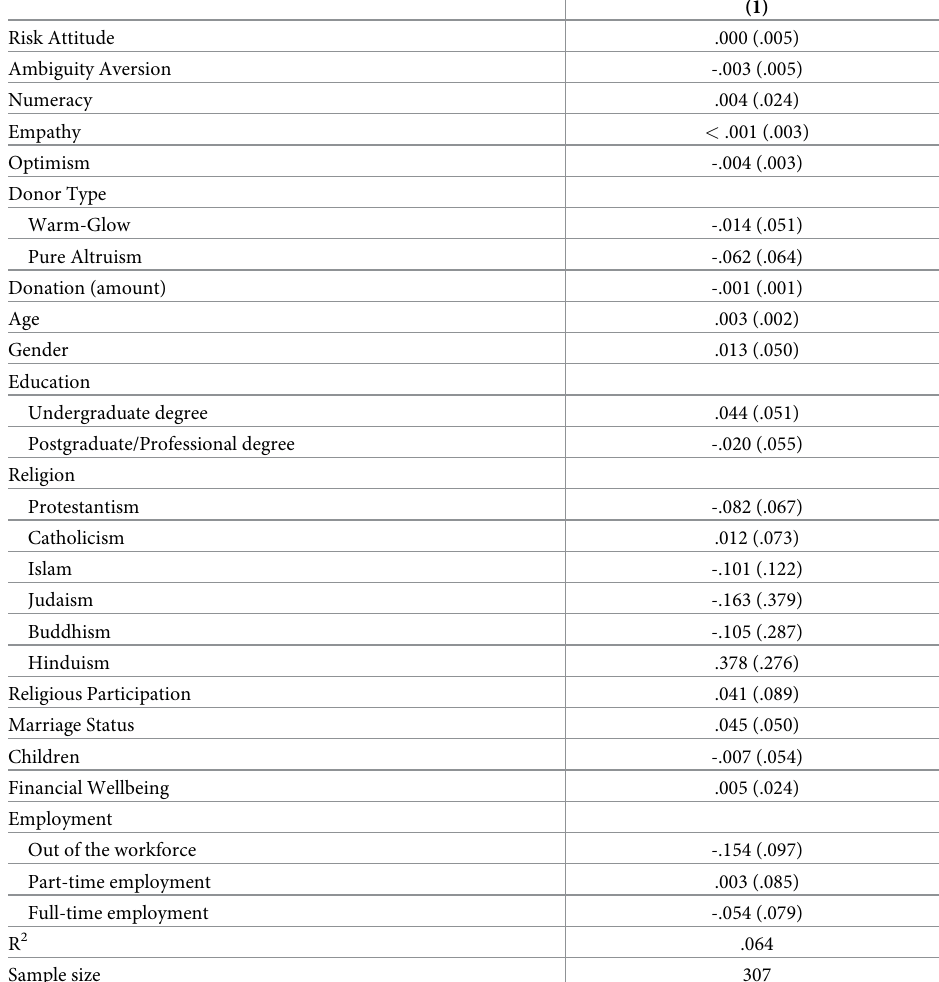
Table 3. Regression results for charitable giving behaviour in main choice predicting choice between sure-thing and probabilistic